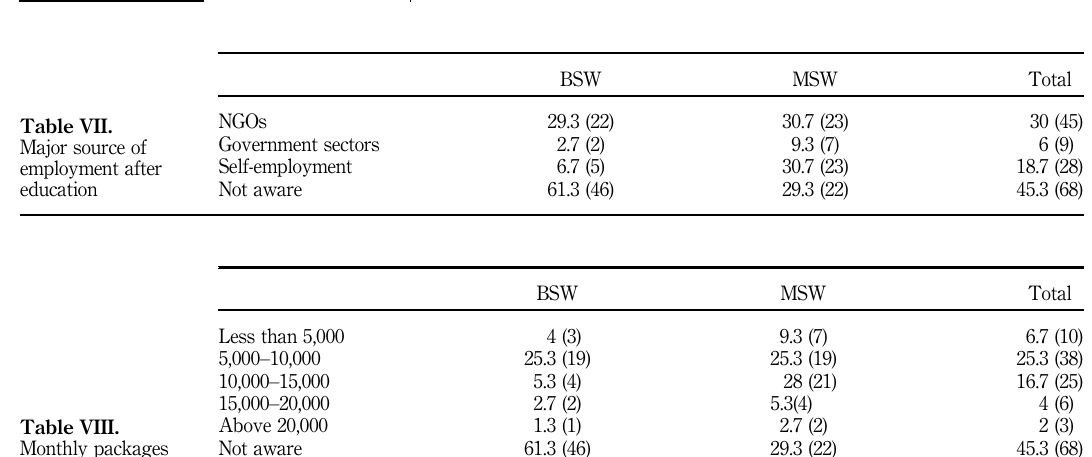
Figure 20. Awareness about